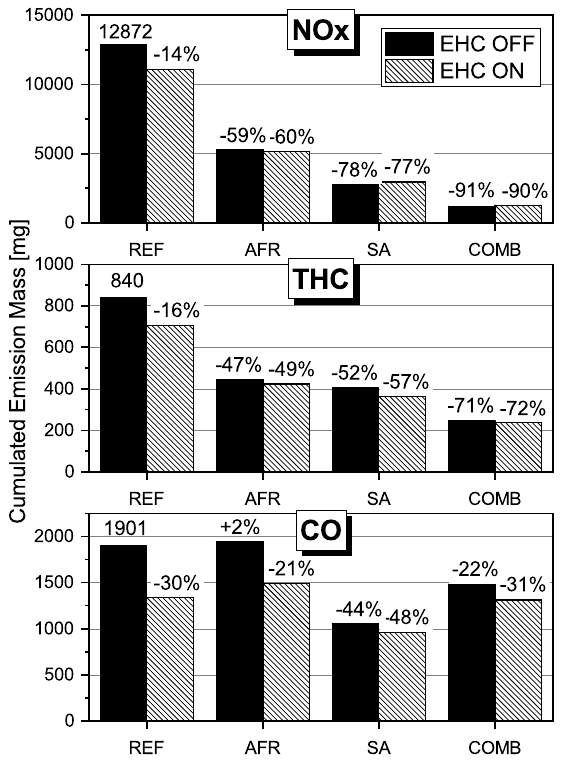
Figure 9. Cumulated emissions with respect to reference case for entire cold-start